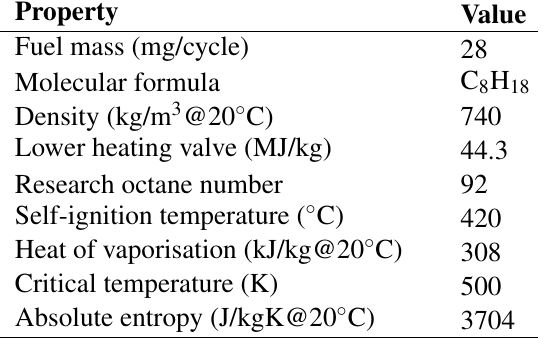
Table 3 Physical and chemical properties of the test